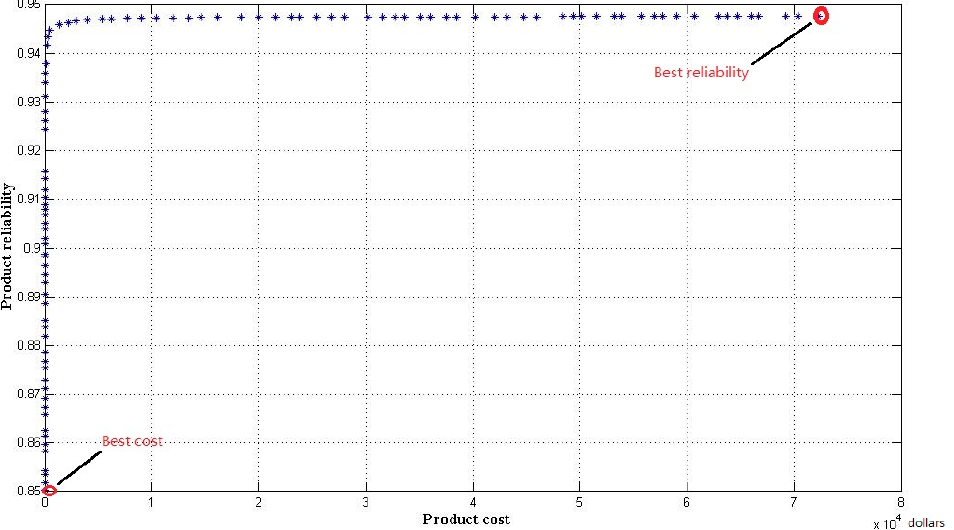
Figure 7. Complete Pareto fronts acquired by culture-based dynamic multi-objective particle swarm optimization (DMOPSO).